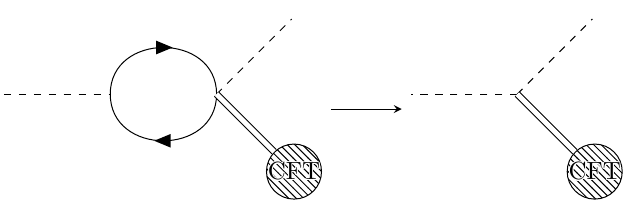
Figure 6 . Example of the operator mixing 1